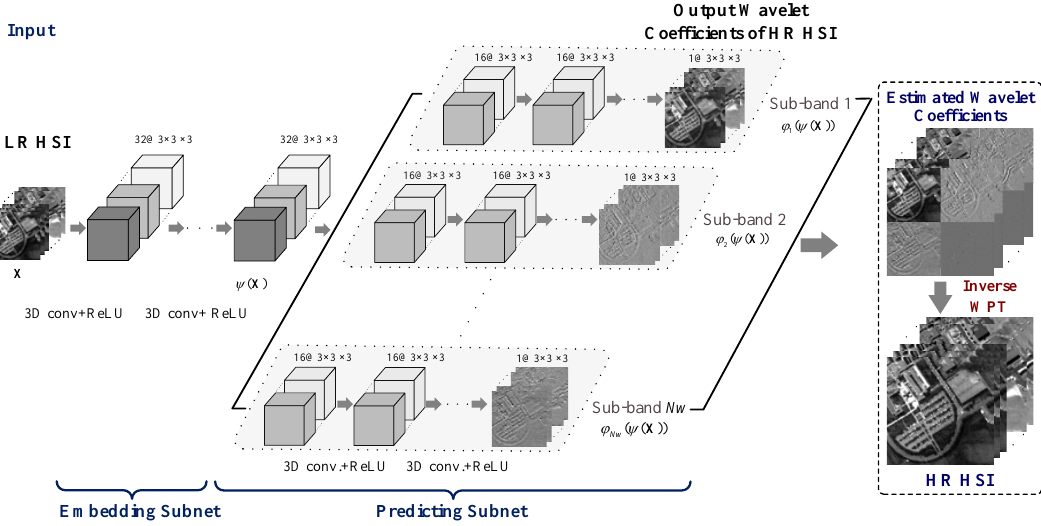
Figure 3. The architecture of the proposed multi-scale wavelet (MW)-3D-CNN, the number and the size of convolutional kernels are denoted at each layer, and the embedding subnet and predicting subnet have three and four layers respectively.